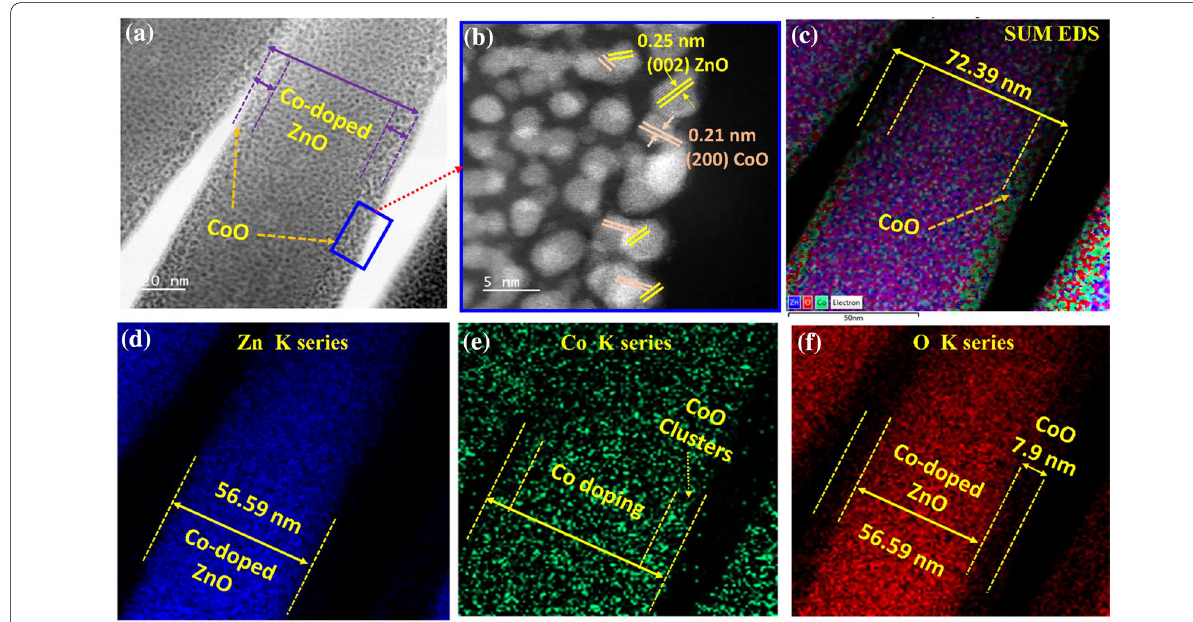
Fig. 2 a Low-resolution (20 nm) STEM image of CO/CZO heterostructure nanorods and b high-resolution (5 nm) STEM image of the area enclosed by a blue rectangle in a . c Sum EDS mapping image of a , which consists of three colors—blue, green, and red—that specify the availability of d